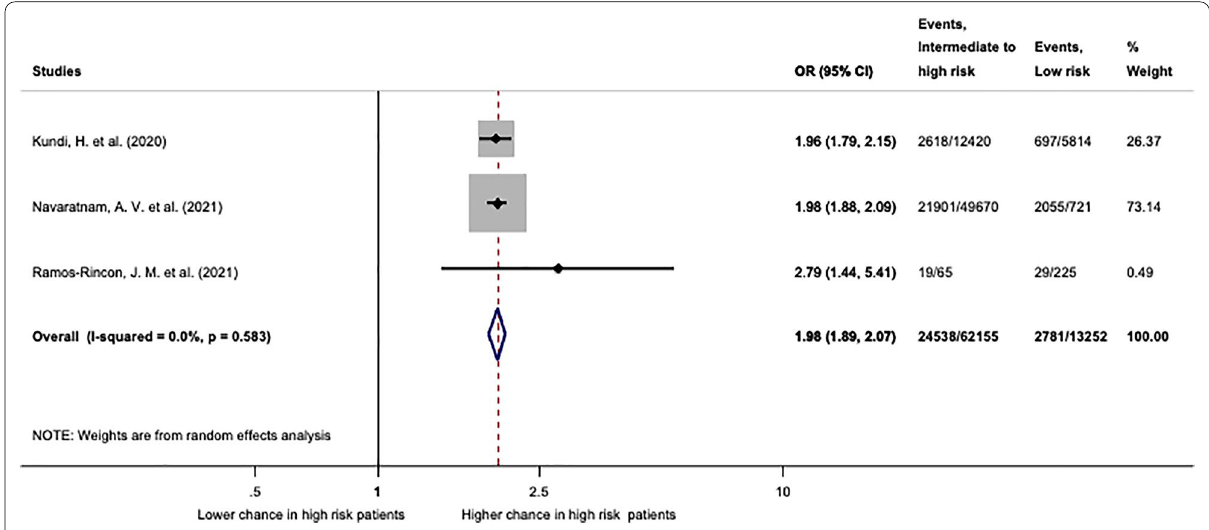
Fig. 4 Mortality assessed by the Hospital Frailty Risk Score. Patients with intermediate and high risk (HFRS mortality (OR: 1.98; CI 1.89–2.07) compared to patients with low risk of frailty (HFRS < 5). This analysis was statistically homogeneous ( I 2 p 0.583). OR: odds ratio; CI: confidence interval. p < 0.1 was considered =